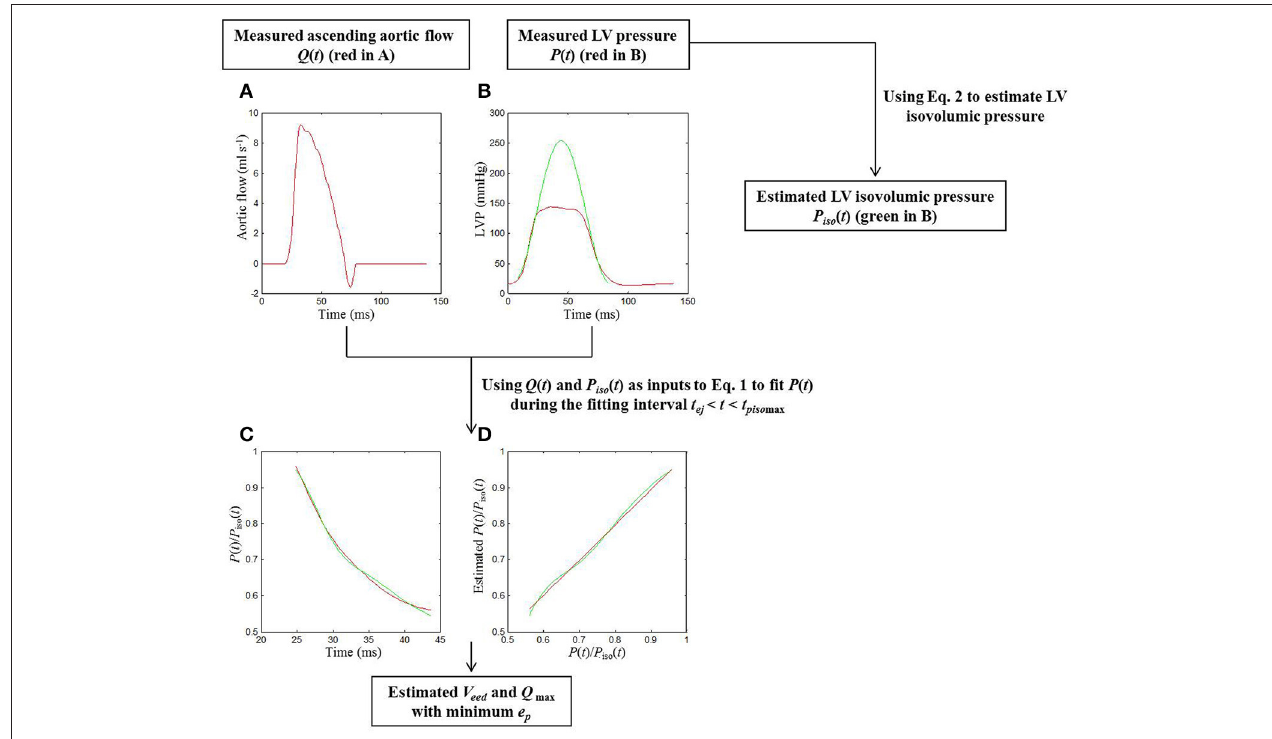
FIGURE 1 | Procedures for the estimation of cardiodynamic parameters using the elastance-resistance model in a sham rat. In Graph (A) , the red curve shows the measured Q(t) . In Graph (B) , the isovolumic portions of the measured P ( t ) (the red curve) were used to estimate the P iso ( t ) (the green line) using (Equation 1). Taking Q ( t ) and P iso ( t ) as 2 inputs into (Equation 2), a good similarity between the computed and measured P ( t ) was observed when the (Equation 2) was fit over t ej < t < t piso max ,asshownin (C,D) .InGraph (C) ,themeasureddataaredescribedintermsoftheredline;themodel-deriveddataarerepresentedbythegreenline.InGraph (D) , the scatter diagram between measured and model-generated data is described by using the green line. The red line is the simple linear regression line of measured and model-generateddata,withaslopeofapproximately1(0.973).Thus,themodelparameters V eed and Q max weredeterminedwiththeminimum e p . e p ,root-mean-square error; LV, left ventricular; P ( t ), measured LV pressure; P iso ( t ), estimated LV isovolumic pressure; P ( t )/ P iso ( t ), ratio of P ( t ) to P iso ( t ); Q ( t ), measured ascending aortic flow; Q max , theoretical maximum flow; t ej , the onset of ventricular ejection; t piso max , the time of the peak isovolumic pressure; V eed , effective LV end-diastolic volume.